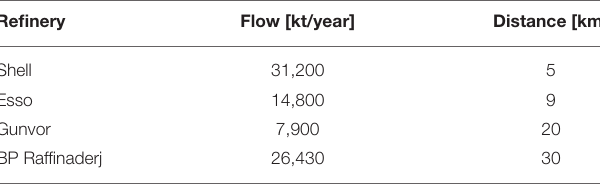
TABLE 6 | Refinery yearly flow and distance from the district. Refinery Flow [kt/year] Distance [km]